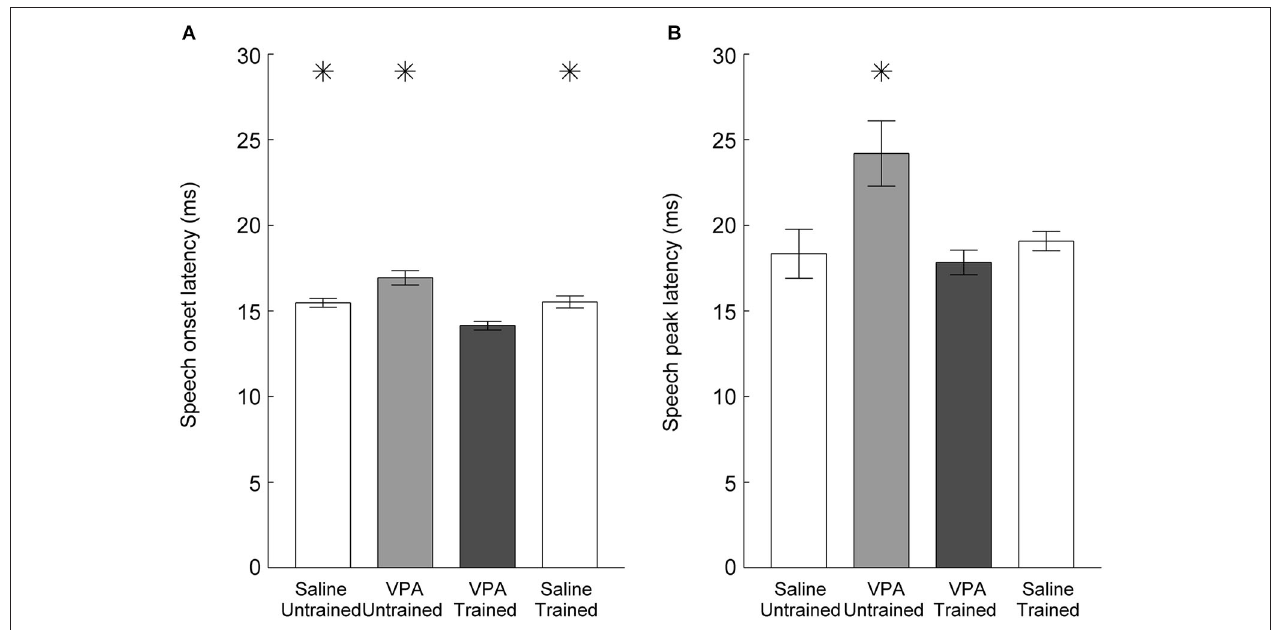
The slower peak latency to speech sounds observed in VPA untrained rats is restored following speech training. Asterisks indicate groups that are statistically significant compared to VPA speech trained rats ( p < 0.05).